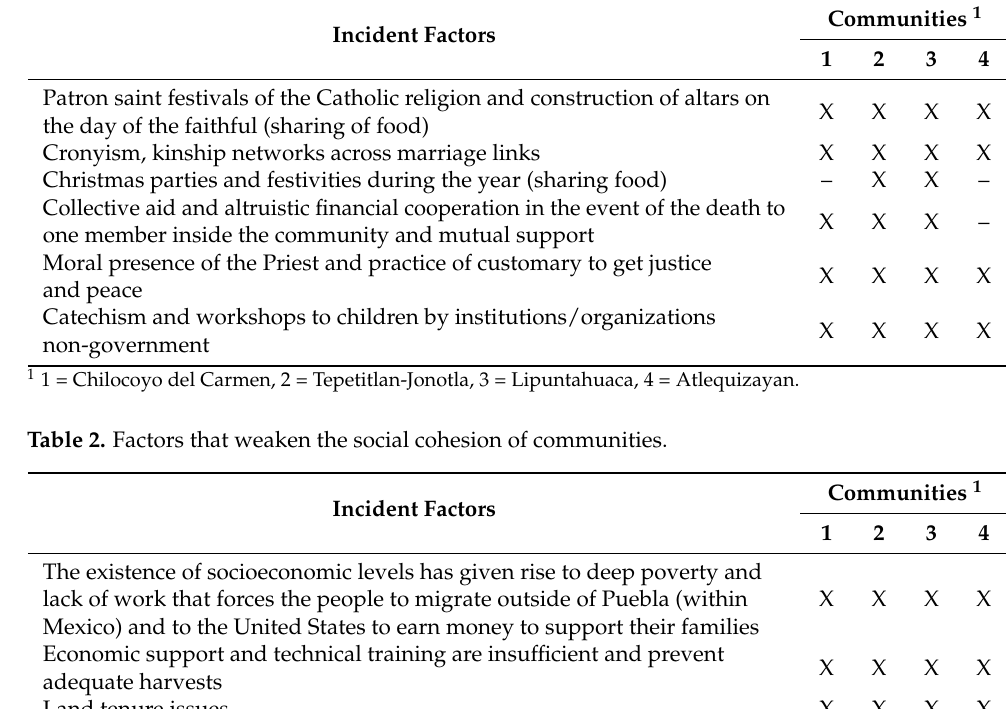
Communities 1 X X X X